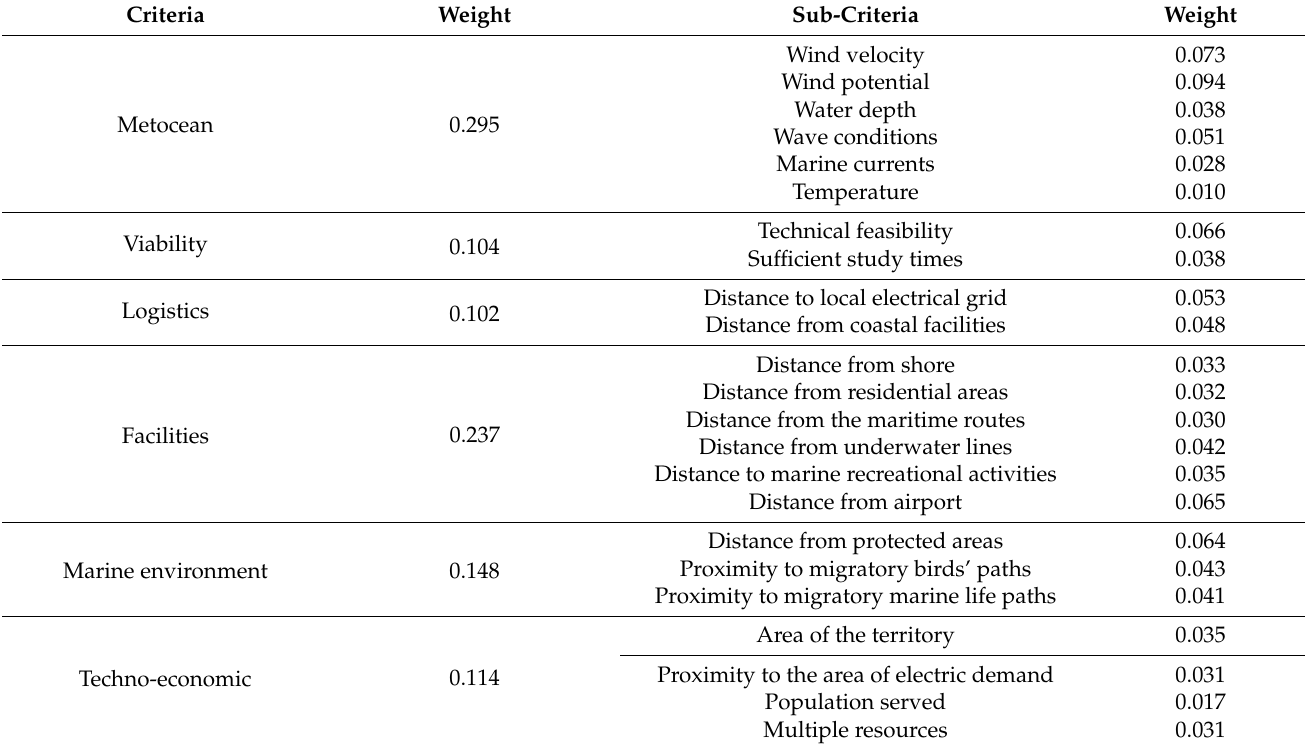
Table 6. The effective weight of criteria and